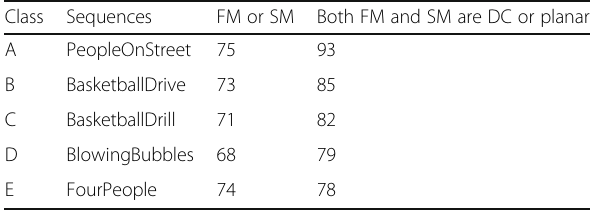
Table 2 The percentage (%) of the best mode is FM or SM Class Sequences FM or SM Both FM and SM are DC or